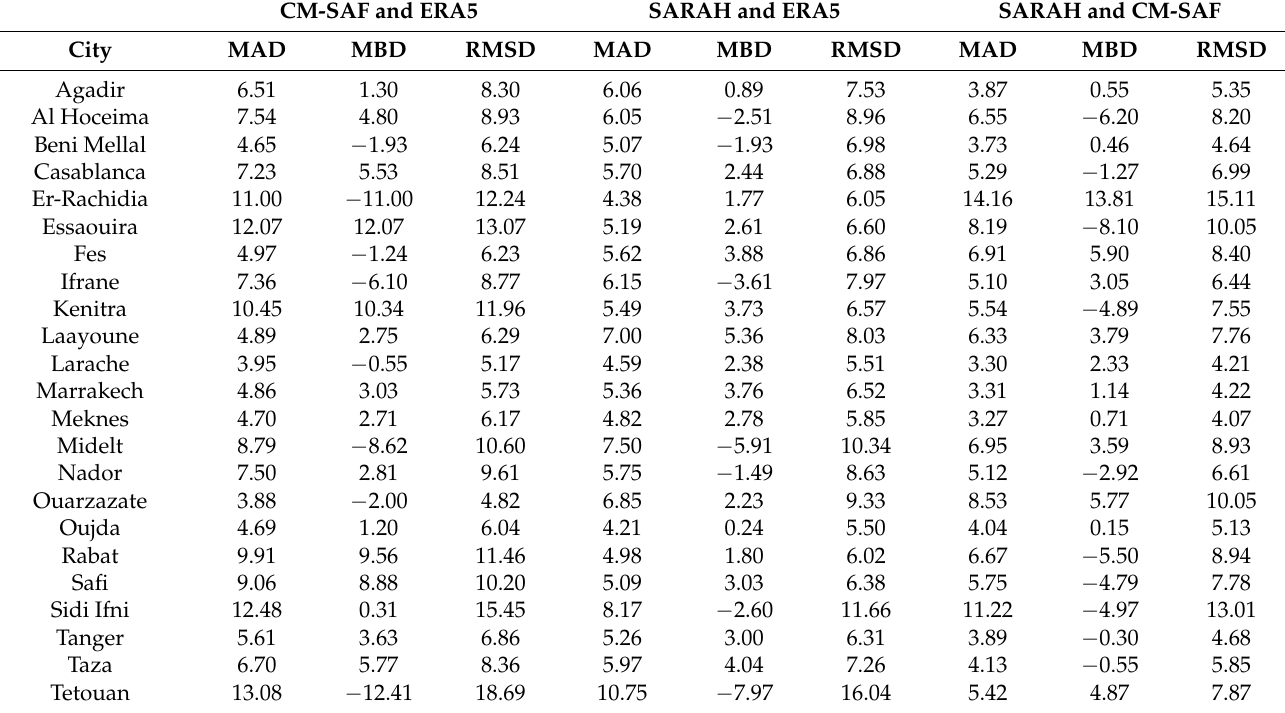
Table 4. MAD, MBD and RMSD for GHI [Wh/m 2 ]. Source: own